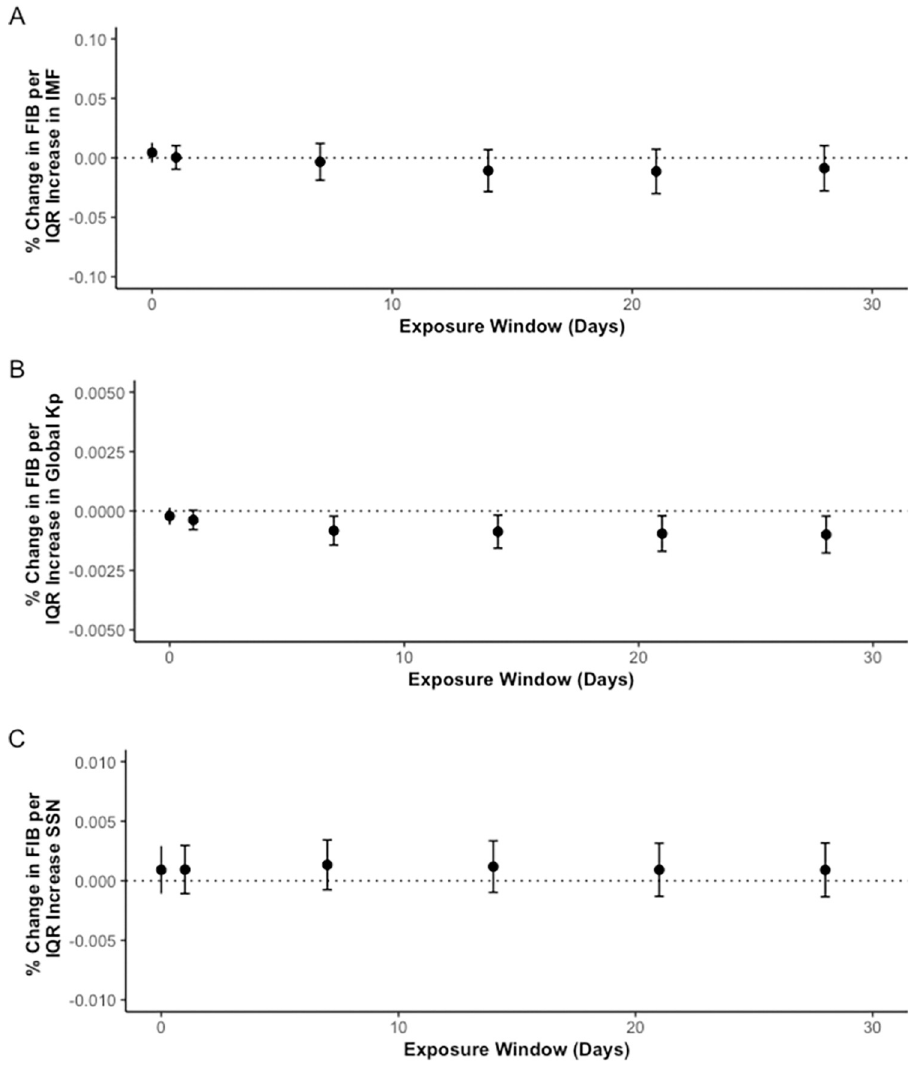
Fig 4. Percent change fibrinogen (FIB) concentrations per IQR increase in IMF (A), K p index (B), and SSN (C) over 28 day moving averages. � y-axes have different